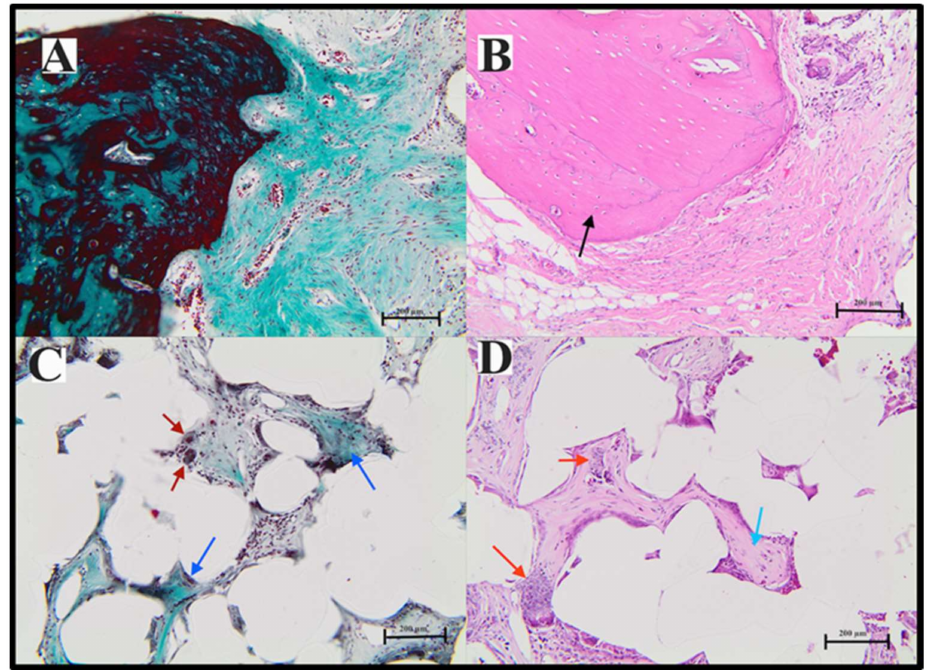
Figure 13. Photomicrographs of decalcified sections stained with hematoxylin and eosin (right) and Masson’s trichrome stain (left) demonstrating the area of bone regeneration at the surgical defect using coated porous polyethylene. ( A , B ) are sections through the area at the interface between the bone border of the defect and the implanted coated polyethylene. The bone shows active remodeling, and the connective tissue next to the bone is highly rich with collagen (green) and osteoblasts and preosteoblast-like cells. ( C , D ) show sections from the center of the scaffold; the interpore spaces are full of connective tissue that turned into bone and osteoid ( C , D blue arrows). The presence of hydroxylapatite is noted ( D , red arrow). There are also giant cells seen mainly in this section ( C , red